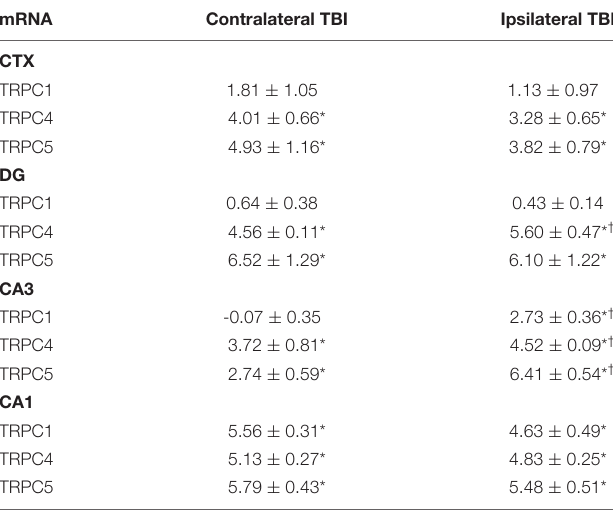
TABLE 1 | Normalized fold change in TRPC1/4/5 mRNA (2 − (cid:49)(cid:49) CT ) in TBI mice compared to